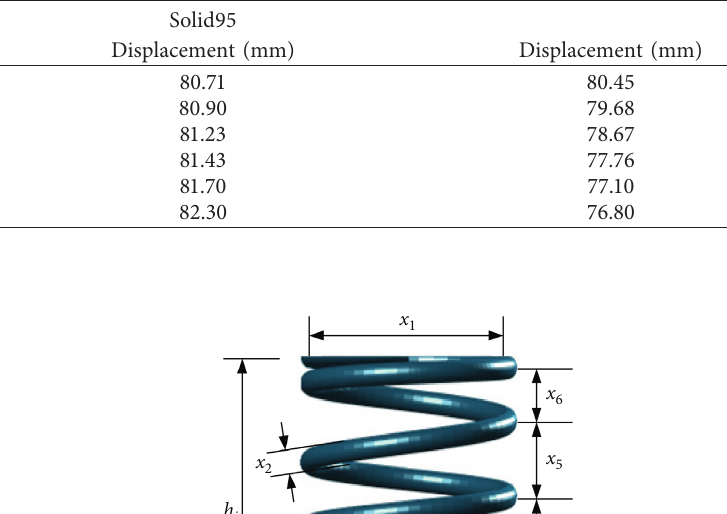
Table 4: Comparison of spring displacement results with ANSYS.